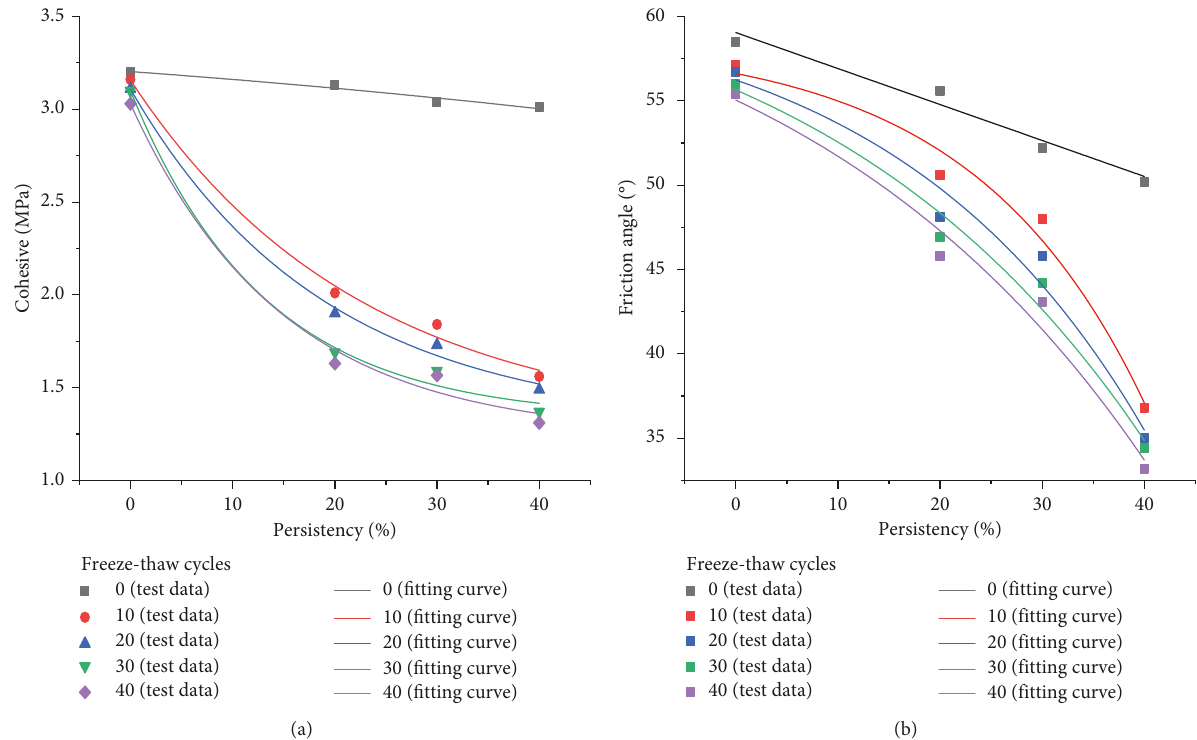
Figure 14: Variation law of shear strength parameters of joint specimens with persistency: (a) variation law of cohesive and (b) variation law of friction